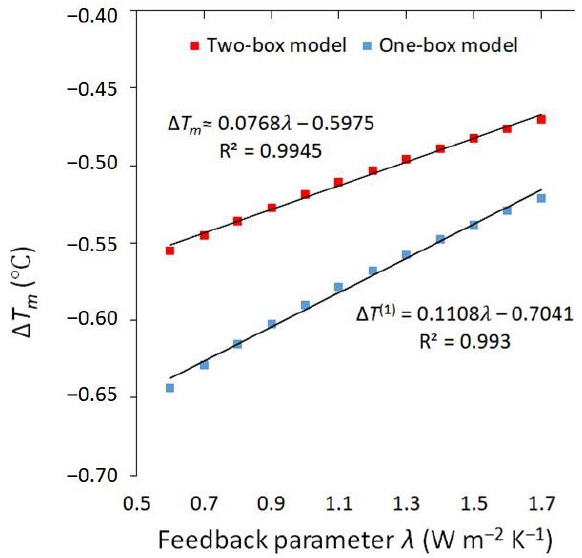
Figure 4. Climate system response Δ𝑇 𝑚 (℃) to volcanic aerosol radiative forcing as a function of climate feedback parameter 𝜆 (W m −2 K −1 ).